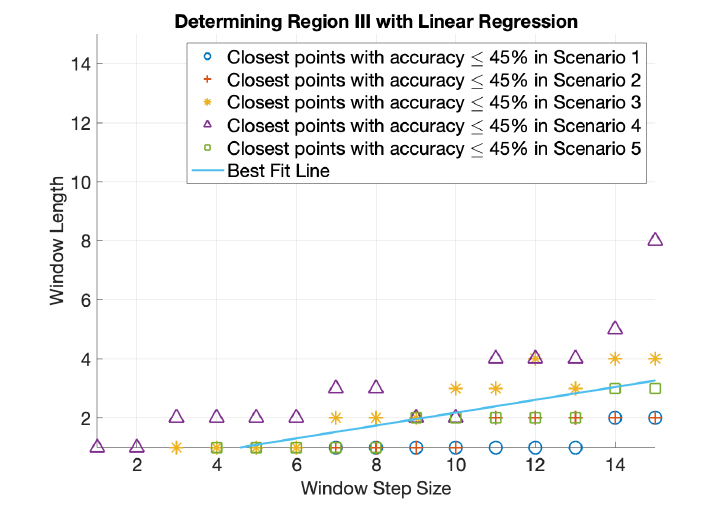
Figure 4. Determining region III with linear